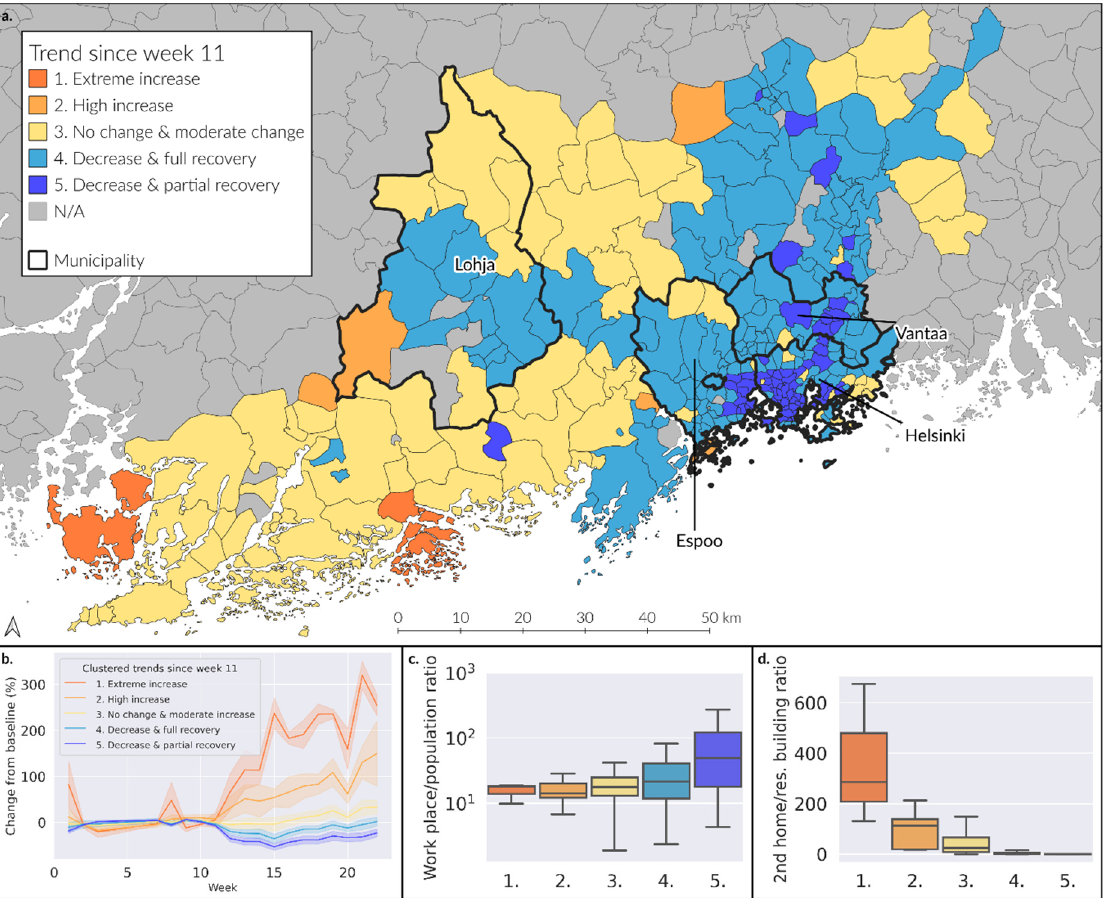
Figure 6. The spatial distribution of postal code areas in the Hospital District of Helsinki and Uusimaa (HUS) region by cluster type ( a ) based on the temporal dynamics of the presence of people from the baseline (6 January–14 March, 2020) ( b ). Box plots indicate the distribution of postal code areas by cluster type regarding the ratio of workplaces to population ( c ) and the ratio of second homes to residential buildings ( d ).